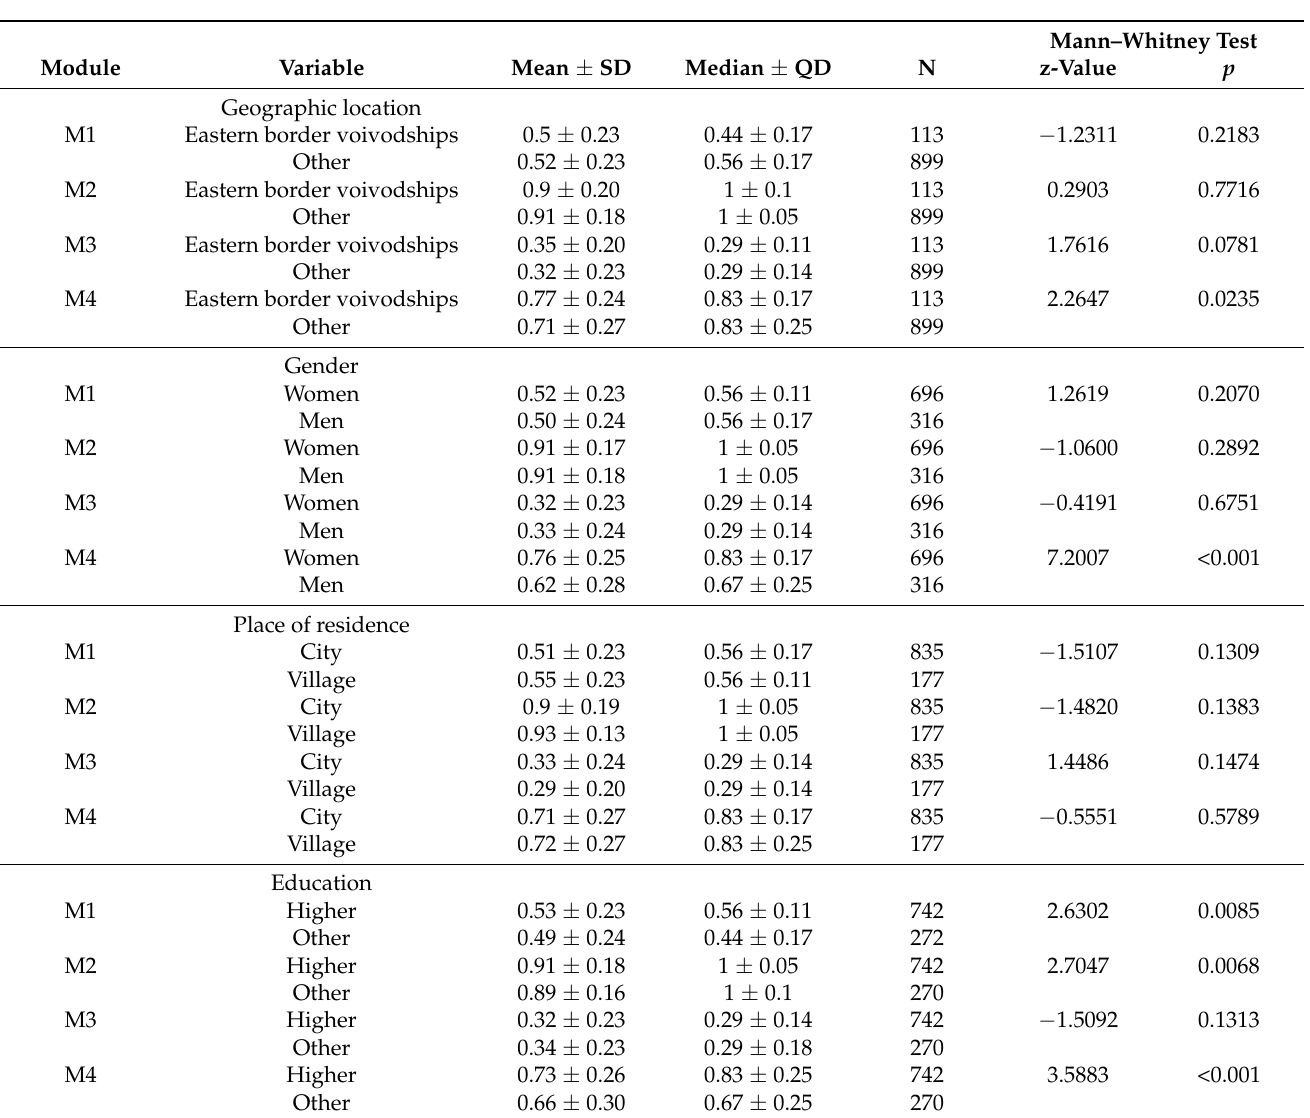
Table 3. Comparison of the answer of the given question (module M1–M4) with geographic location, gender, place of residence, and